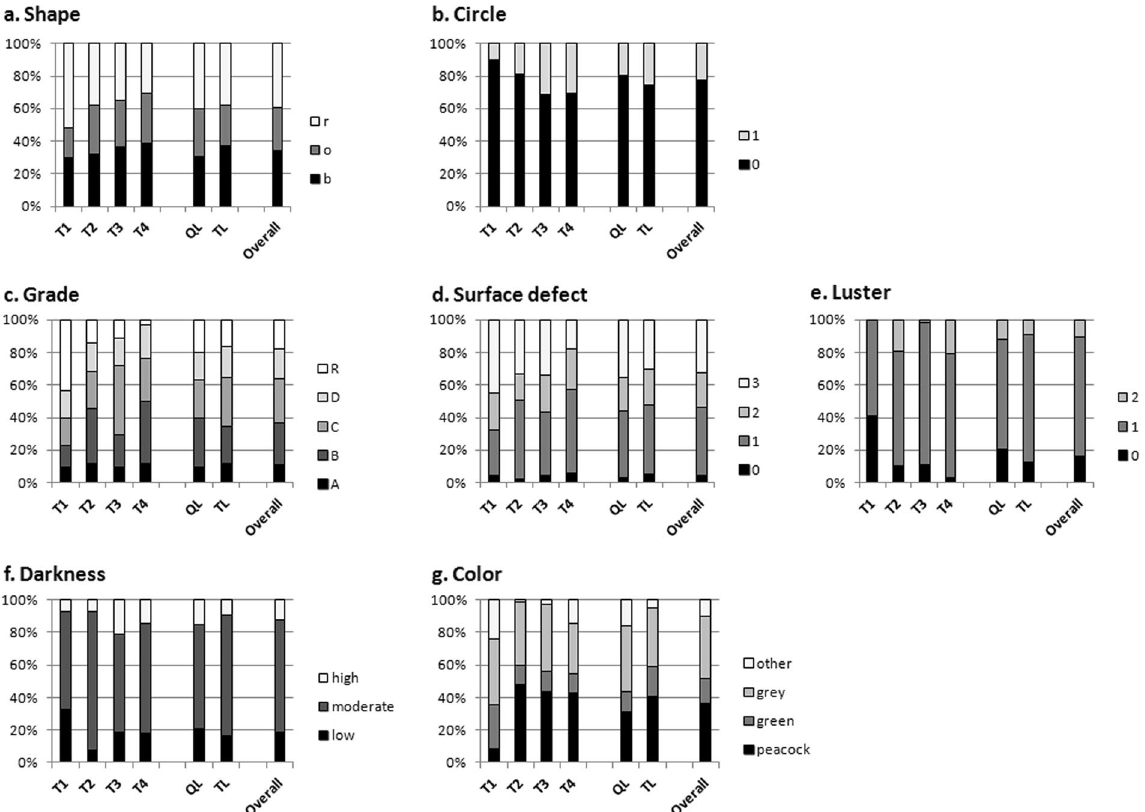
Figure 2. Cultured pearl quality traits from the experimental graft distribution. Percentage of cultured pearls for each harvest time (T1 corresponds to 3 months of culture, T2 to 6 months, T3 to 9 months and T4 to 12 months), for each donor phenotype (groups QL and TL) and for the overall harvest among the following variables are presented: ( a ) shape categories (“b” for baroque and semi baroque, “o” for oval and drop,” r” for round and semi round pearls), ( b ) pearl circles (“0” = absence and “1” = presence), ( c ) classification grade (“A” to “D” and Rejects), ( d ) surface defect classes (“0” = 0 defects, “1” = 1–5 defects, “2” = 6–10, and “3” = > 10 defects), ( e ) luster levels (“0” = absence of luster, “1” = moderate luster, and “2” = high luster), ( f ) darkness level (low, moderate and high darkness) and ( g ) visual color categories (“peacock”, “green”, “grey” and “other”, corresponding to white and yellow